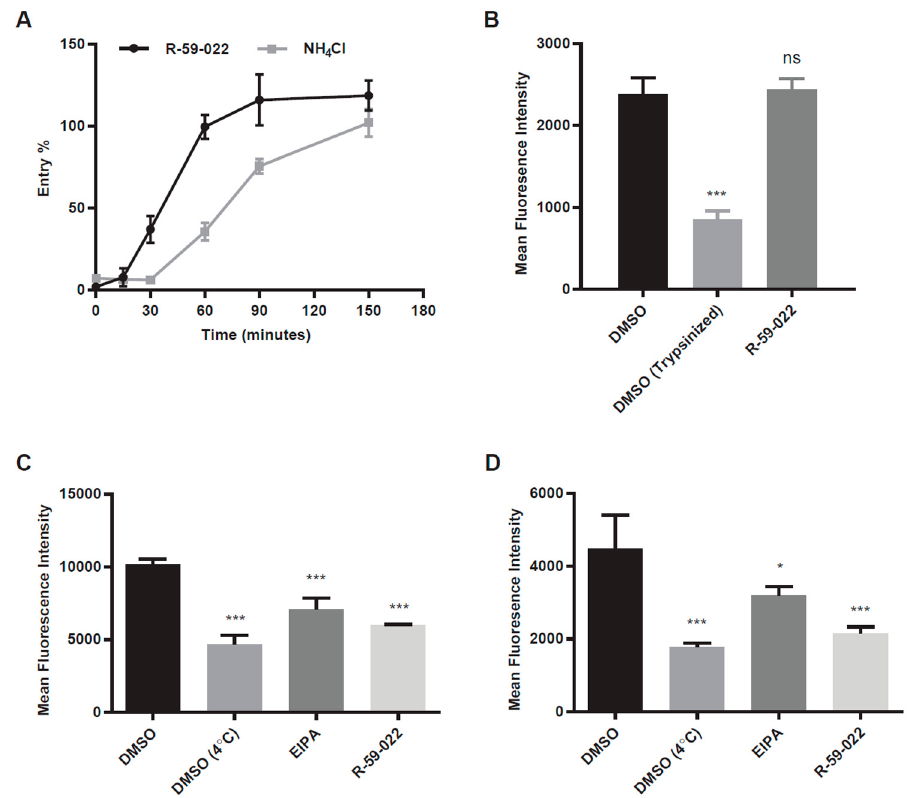
Figure 3. R-59-022 blocks internalization of EBOV VLPs into the host cell. ( A ) Time of addition assay in Vero cells with β lam VLPs harboring EBOV GP. Cells were infected at t = 0 and R-59-022 (5 µ M) or NH 4 Cl (15 mM) were added at indicated time points post-infection. Viral entry was measured by determining the percentage of cells with cleaved CCF2 compared to vehicle; ( B ) Attachment assay in Vero cells using mCherry VLPs harbouring EBOV GP. Vero cells were pre-treated with 5 µ M R-59-022 or vehicle followed by a 1-hour incubation at 4 ◦ C with EBOV VLPs. One set of DMSO samples was trypsinized to remove bound VLPs. Fluorescence of mCherry VLPs was measured by flow cytometry and mean fluorescence intensity (MFI) for each sample determined using the FlowJo software; ( C , D ) Internalization assay in ( C ) Vero cells and ( D ) BMDMs using mCherry EBOV VLPs. Cells were pre-treated with 5 µ M R-59-022, 30 µ M EIPA, or vehicle followed by addition of VLPs and spinoculation at 4 ◦ C. Cells were washed with cold PBS and pre-warmed media containing inhibitor or vehicle was added. Cells with attached VLPs were incubated at 37 ◦ C for 1 h to allow for internalization and were then moved to 4 ◦ C for 15 min. Cells were then trypsinized at 4 ◦ C for 30 min to remove non-internalized VLPs. Fluorescence of internalized mCherry VLPs was measured by flow cytometry and mean fluorescence intensity determined using the FlowJo software. Data are representative of 3 independent experiments. * p < 0.05, ** p < 0.01, *** p < 0.001, ns: not